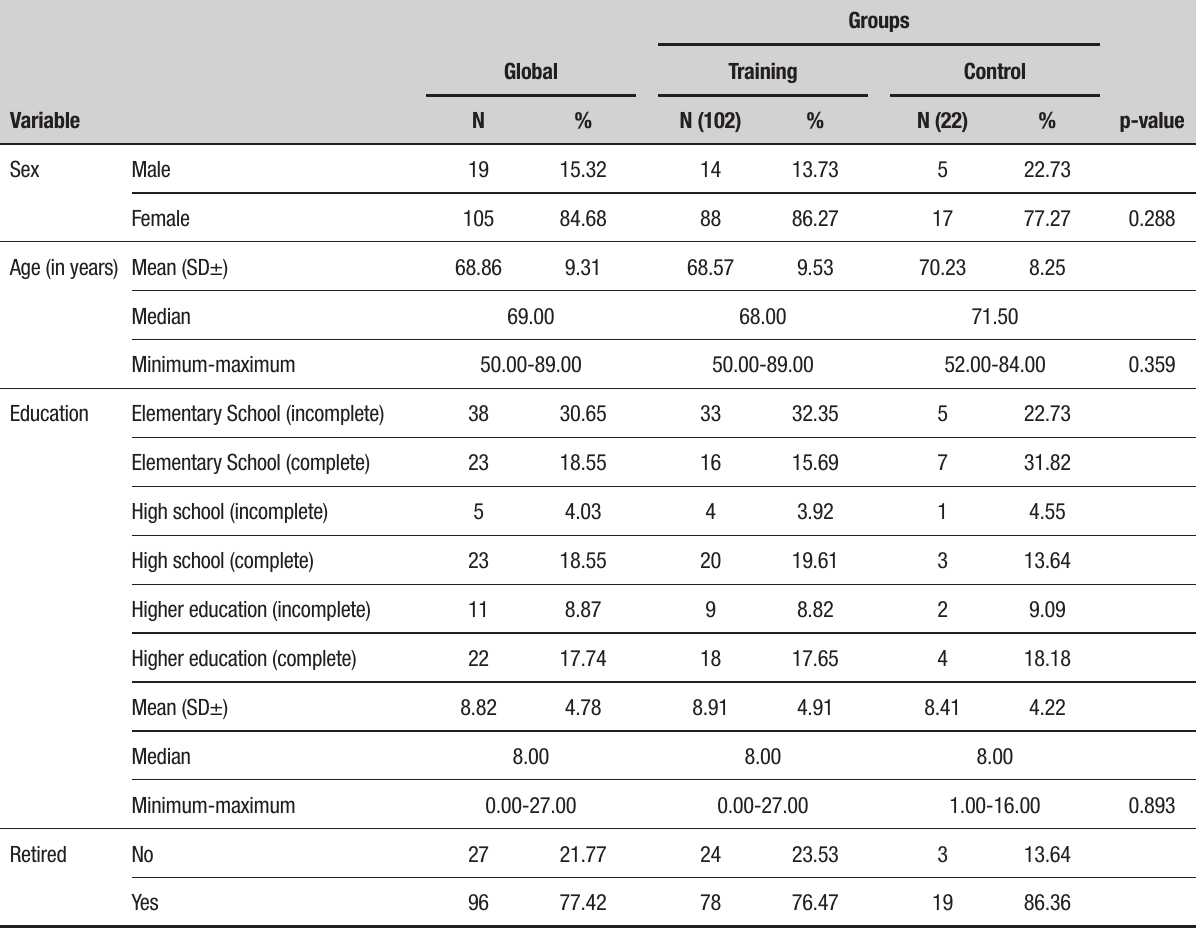
Table 1. Socio-demographic profile of